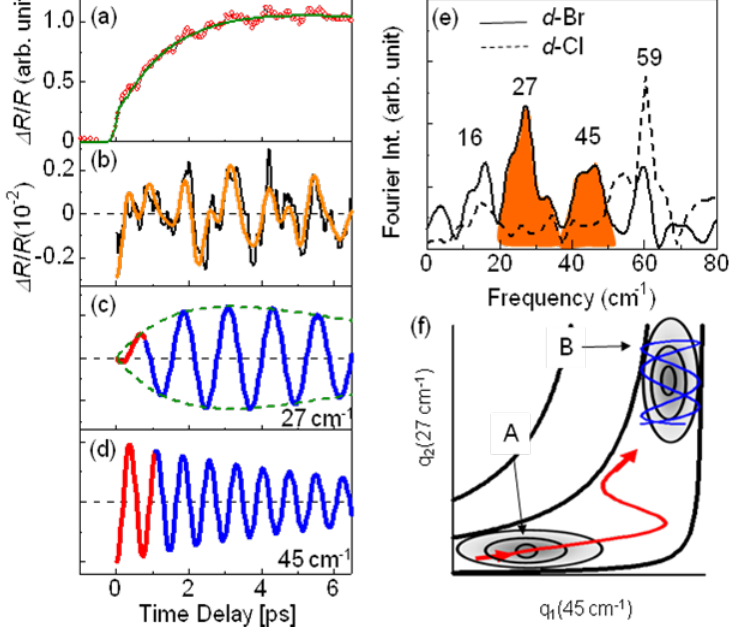
Figure 20. ( a ) Time evolutions of  R/R for d -Br detected at 0.26 eV under excitation at 0.89 eV (red circles with green fitted curve); ( b ) The time profile of the oscillating component of  R / R for d -Br (0.89 eV excitation); ( c , d ) The 27 cm –1 ( c ) and 45 cm –1 ( d ) cosine-like oscillations, which were obtained through analysis (see the text); ( e ) Fourier transformed spectra of the oscillation for d -Br and d -Cl; ( f ) Classical trajectories representing coherent phonon dynamics in the potential surface. A and B respectively denote the excited Mott insulator state and the photoinduced metallic state